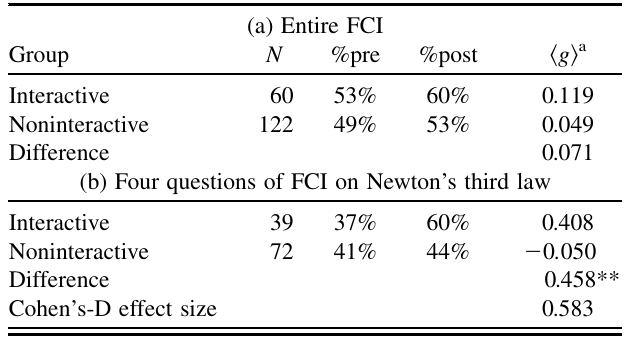
TABLE I. Tests of statistical significance for normalized gain scores on FCI (* p < 0 : 05 , ** p < 0 : 01